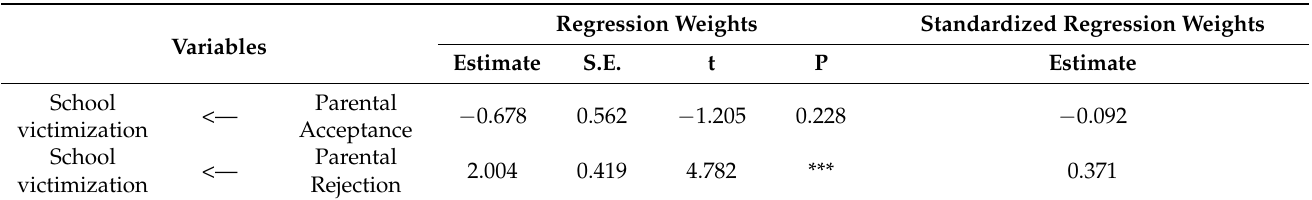
Table 4. Estimates of the effect of parental acceptance and rejection of adolescents on school victim ‐ ization.